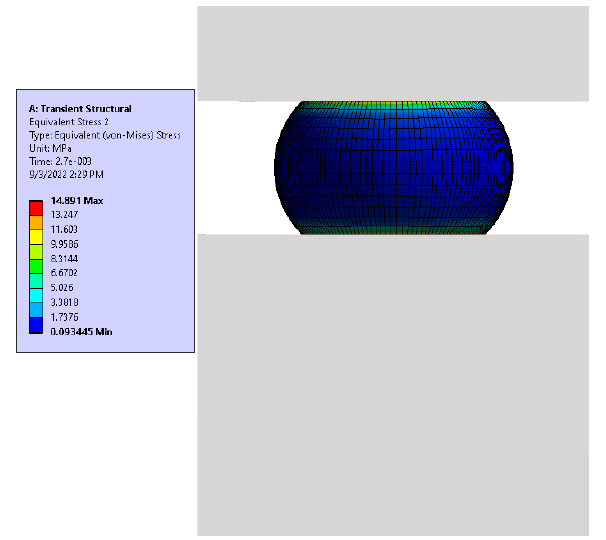
Figure 11. Maximum steady state stress amplitude at the solder ball (sample 1).